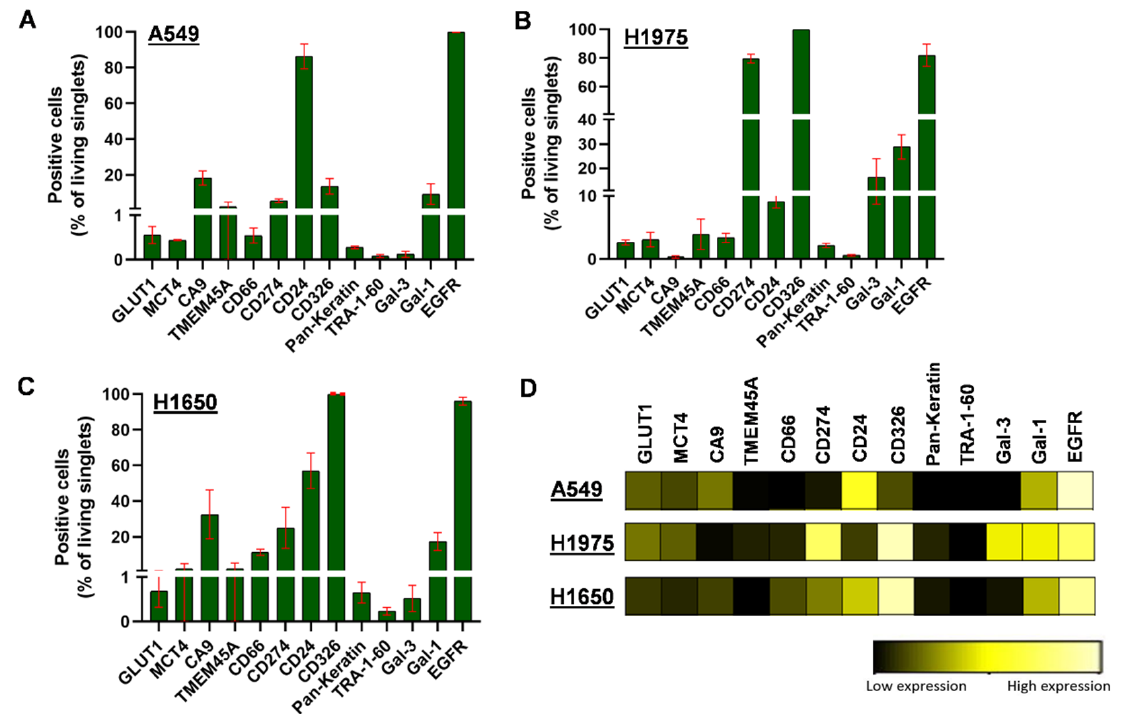
Figure 1. The intra-cell-line heterogeneity of A549, H1975, and H1650 human NSCLC cells analyzed by single-cell mass cytometry. Column bars of the ( A ) A549, ( B ) H1975, and ( C ) H1650 cells show the percentages of live single cells expressing the given cell-surface protein markers. Thirteen protein markers—GLUT1, MCT4, CA9, TMEM45A, CD66, CD274, CD24, CD326, pan-keratin, TRA-1-60, Gal-3, Gal-1, and EGFR—were investigated with single-cell resolution provided by the metal-tag-labeled antibodies used for mass cytometry. ( D ) Heatmap of the expression intensities of the 13 protein markers, which were calculated from the transformed ratio of medians of the table minimum using X-axis channels: panel/channel values.